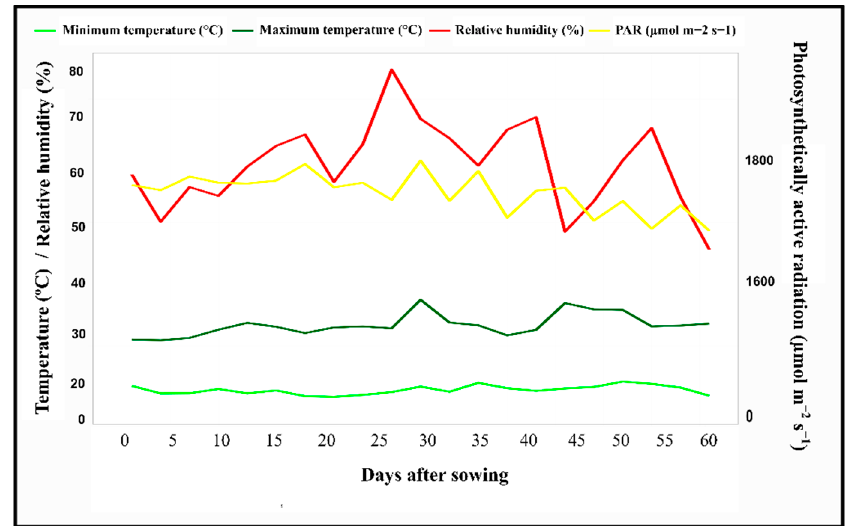
Figure 1. Average minimum (Tmin) and maximum (Tmax) air temperatures (°C), relative air humidity (RH, %), and photosynthetically active radiation (PAR, µmol m − 2 s − 1 ) over the days after the sowing of the popcorn.